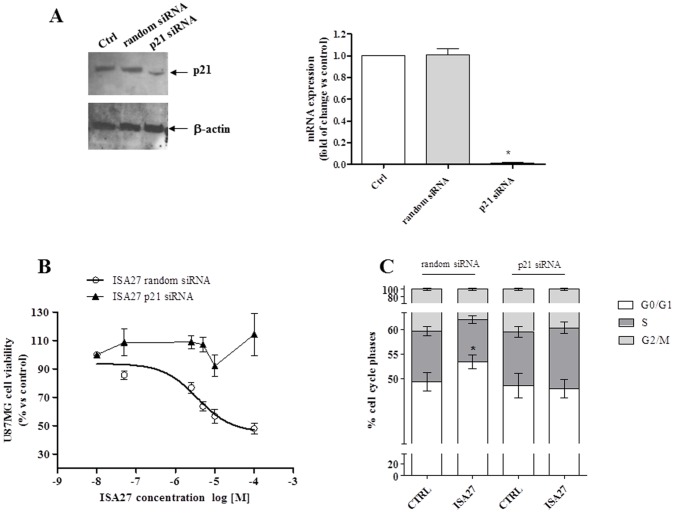
siRNA against p21 abrogates ISA27-mediated cell growth inhibition.A) Evaluation of p21 levels after transient transfection of U87MG cells with p21 siRNA: Western blotting and real-time RT-PCR analyses demonstrated decreased p21 levels in U87MG cells after 24 h transient transfection. B) Evaluation of ISA27 effect on cell viability. p21 siRNA samples were exposed to a range of ISA27 concentrations for 24 h. After incubation, U87MG cell viability was determined by MTS assay. The IC50 value was 3.6±0.5 µM for random siRNA ISA27 sample. Transfection of U87MG cells with p21 siRNA rendered ISA27 much less effective to inhibit cell viability. C) Evaluation of ISA27 effect on cell cycle in p21 siRNA sample: random siRNA and p21siRNA samples were exposed to a fixed dose of ISA27 (5 µM) or DMSO for 24 h. The ISA27-treated random siRNA sample showed the increase of G1 phase compared to random siRNA sample. The comparison of cell cycle phases between p21 siRNA and ISA27-treated p21 siRNA sample did not show statistically significant differences.